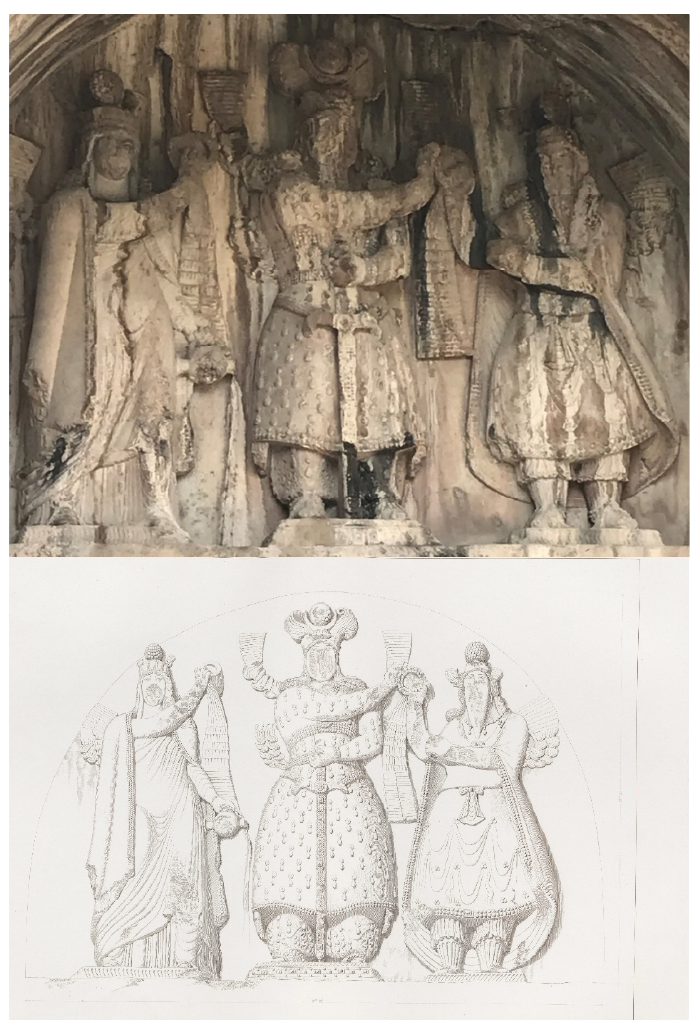
Figure 2. The investiture scene, rock relief, end of the 6th century CE, Taq-e Bustan, The Great Grotto. Photographed by authors, the drawing is taken from: Flandin, E.; Coste, P. Voyage en Perse , Gide et J. Baudry, Paris, France,